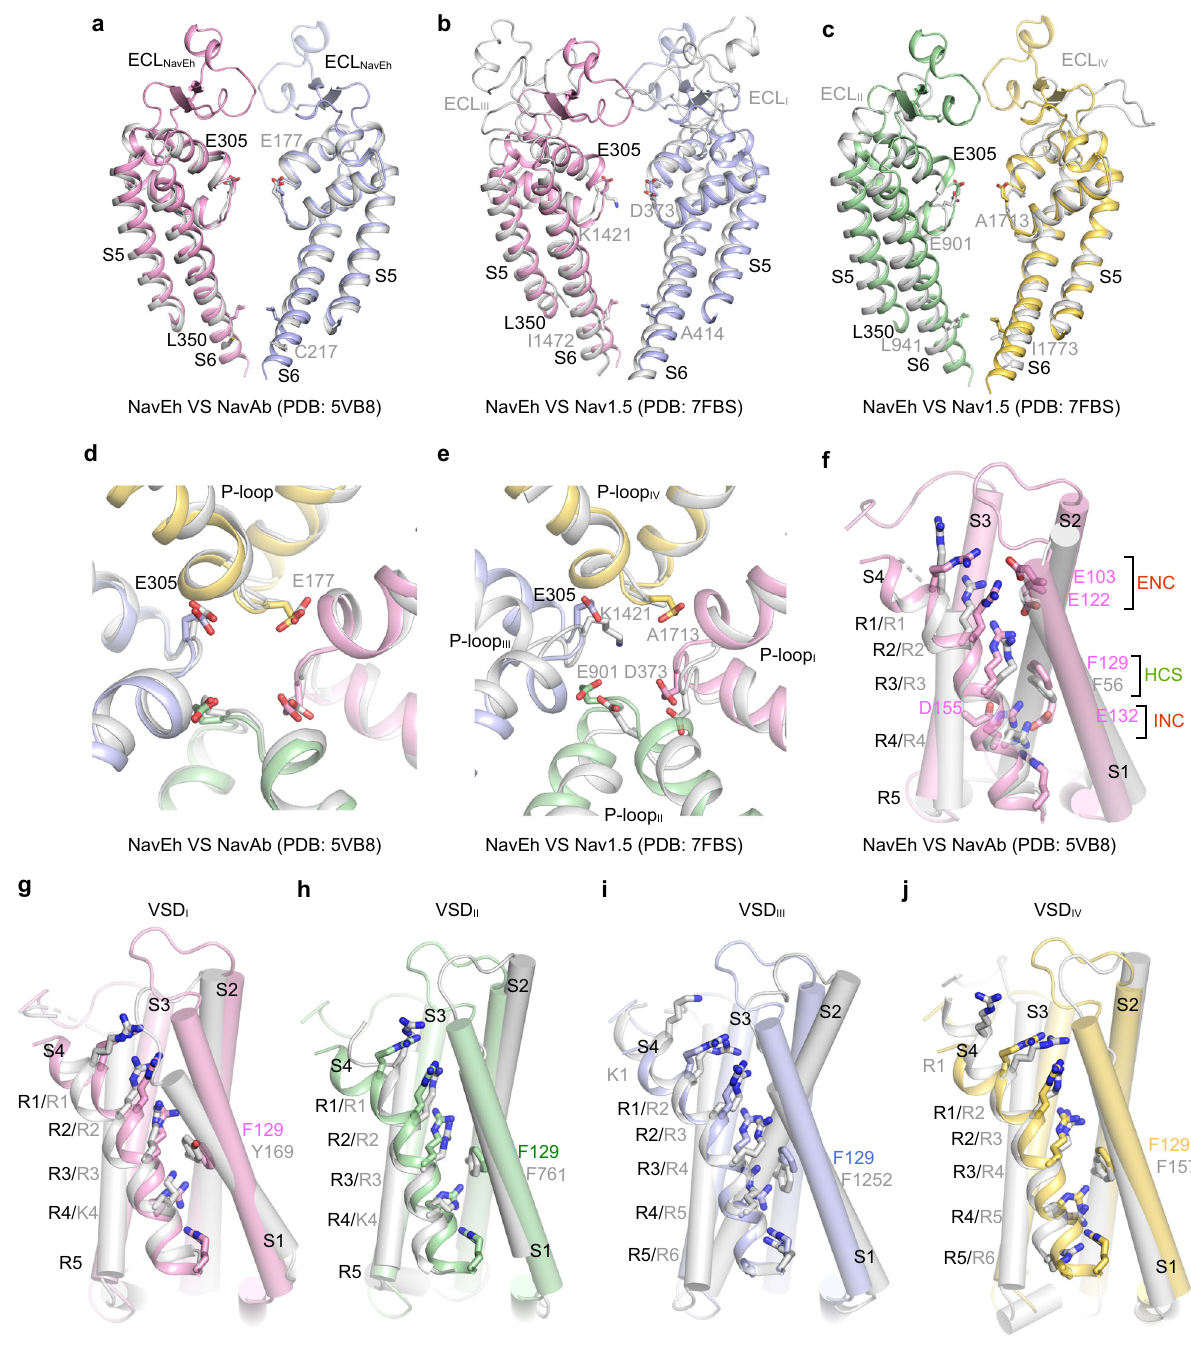
Fig. 3 Structural comparison of Na V Eh with Na V Ab and Na V 1.5. a Pore domain comparison between Na V Eh (pink and light blue) and Na V Ab (PDB: 5VB8, gray), S5 and S6 helices were used for superimposition. b , c Pore domain comparison between Na V Eh and Na V 1.5 (PDB: 7FBS, gray). d , e Selectivity fi lter comparison of Na V Eh with Na V Ab and Na V 1.5, respectively. f VSD comparison of Na V Eh and Na V Ab (gray). The extracellular negatively charged clusters (ENC) and intracellular negatively charged clusters (INC), hydrophobic-constriction site (HCS) were colored in red and green, respectively. g – j VSD comparison between Na V Eh and domain I – IV of Na V 1.5 (gray),